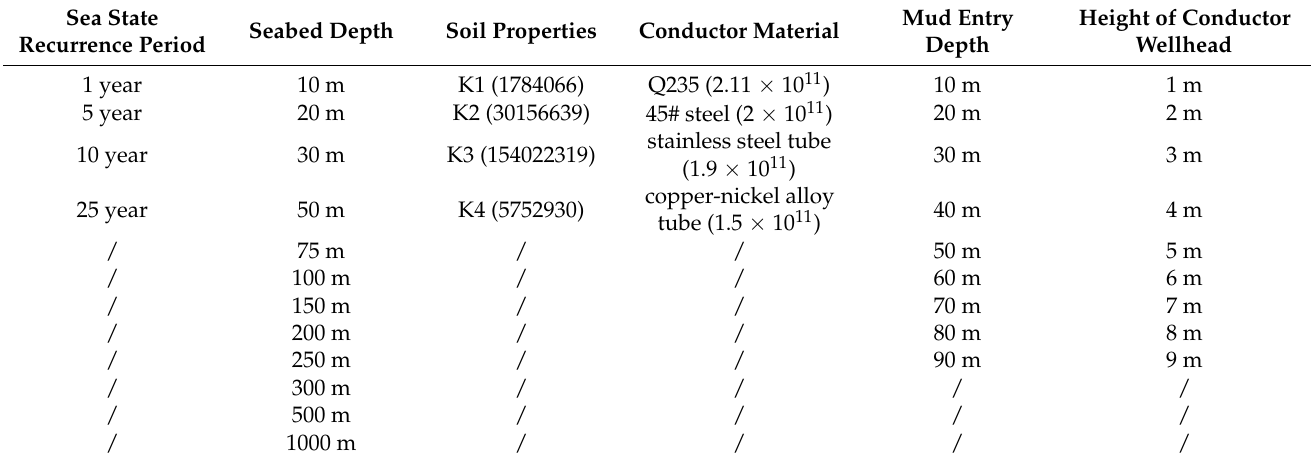
Table 4. The setting of each factor level of conductor